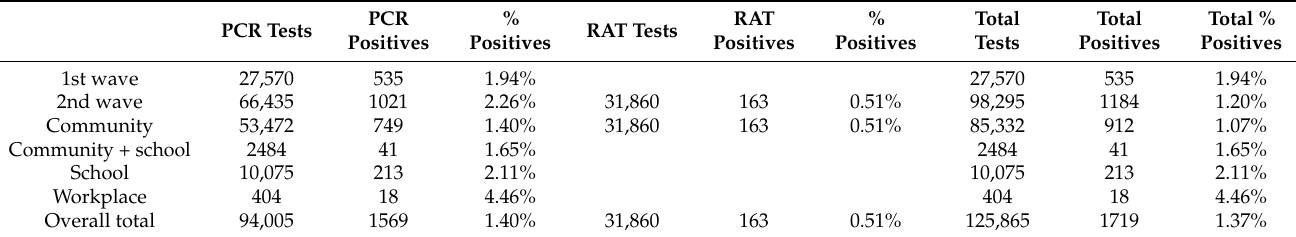
Table 1. Screenings in asymptomatic population. Northern Metropolitan Health Region. July–December